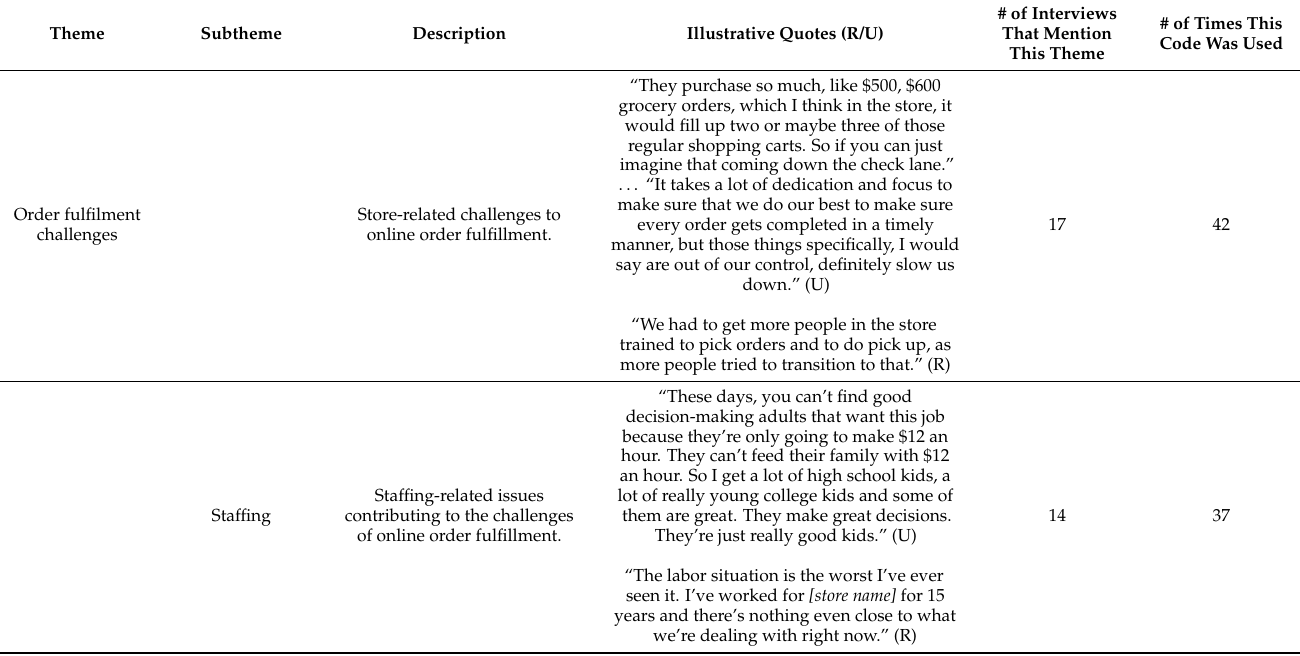
Table 2. Primary emergent themes from qualitative analysis among n = 15 grocery store managers offering online grocery shopping to